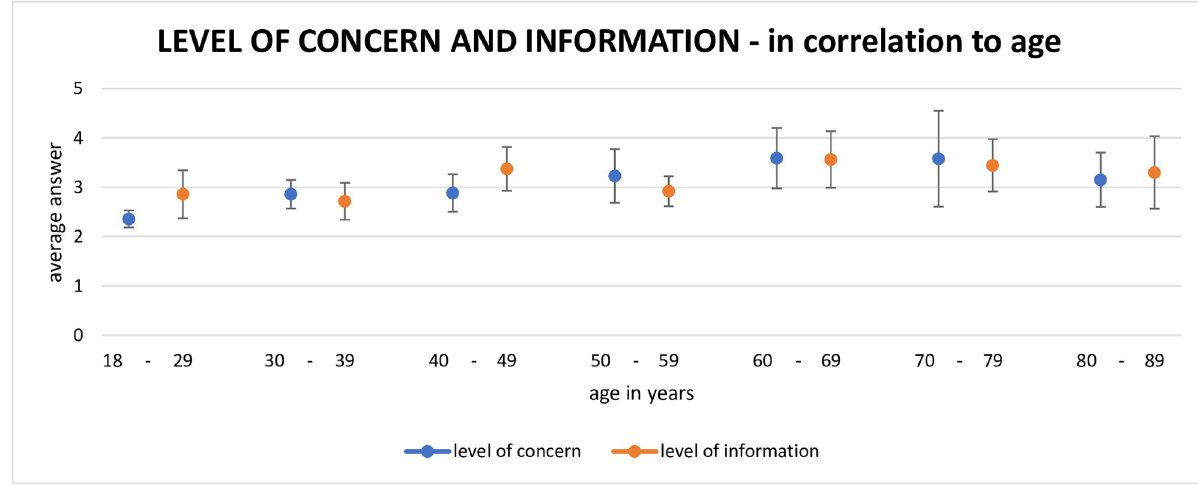
Fig 4. Level of concern and level of information in correlation to age. The graph shows the average answers of the participants according to their age group. 1 is no concern/very basic level of information, 5 is the highest level of concern/information.